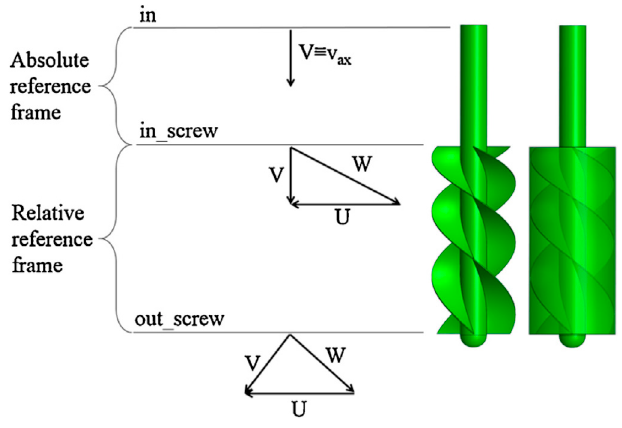
Figure 8. Screw pump with increasing pitch and velocity triangles.